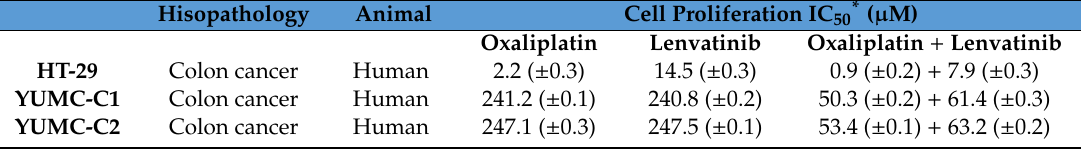
Table 1. IC 50 (half maximal inhibitory concentration) determination using a cell proliferation assay. Oxaliplatin and lenvatinib combination treatment is a lower IC 50 than oxaliplatin and lenvatinib alone. Each data point represents the mean of 3 independent MTT assays for IC 50 performed in triplicate. SD, standard deviation. * p <